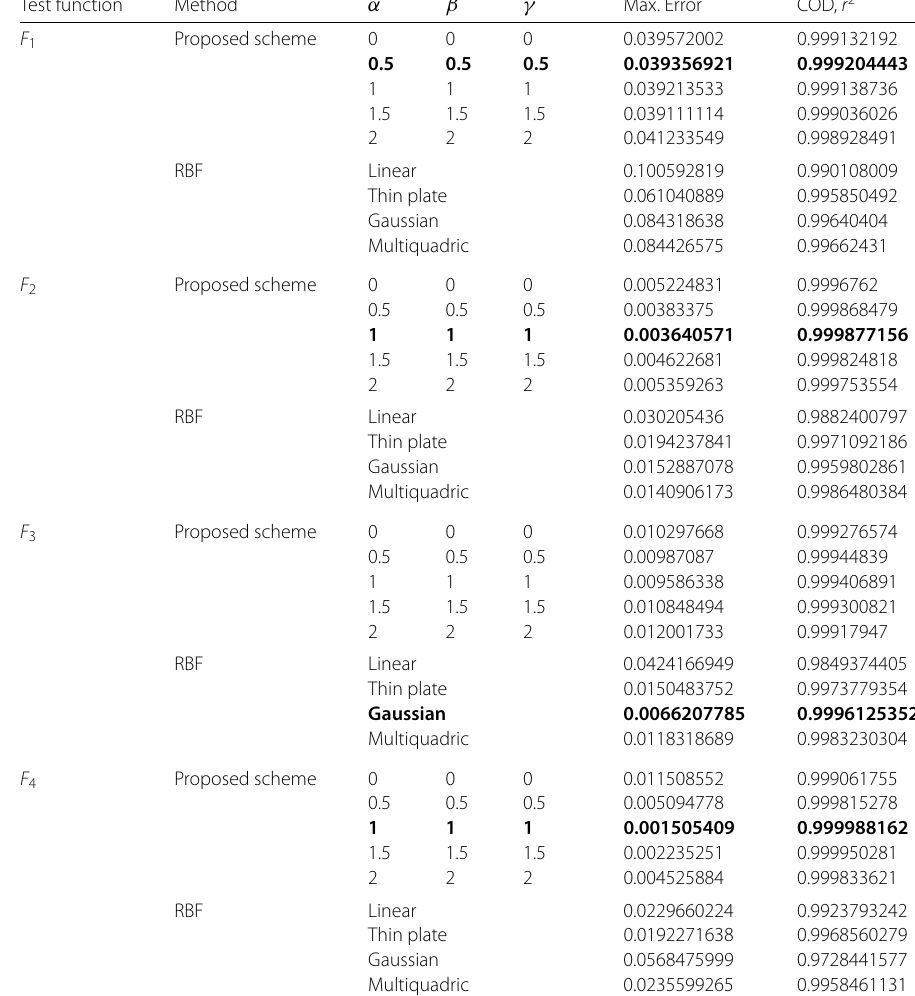
Table 1 Error measurement for 36 data